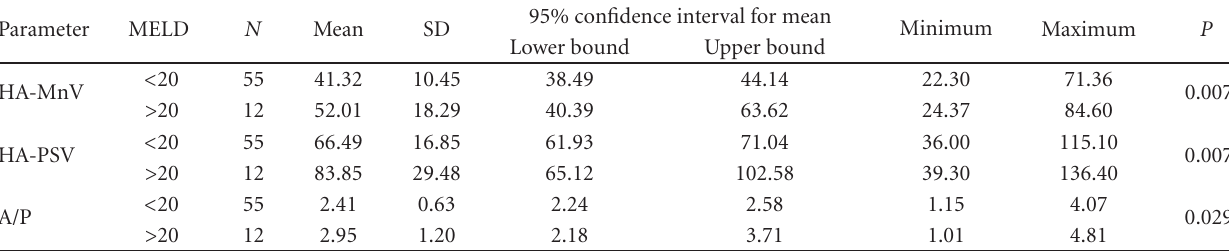
Table 3: Liver Doppler US parameters with significant di ff erences according to MELD score.